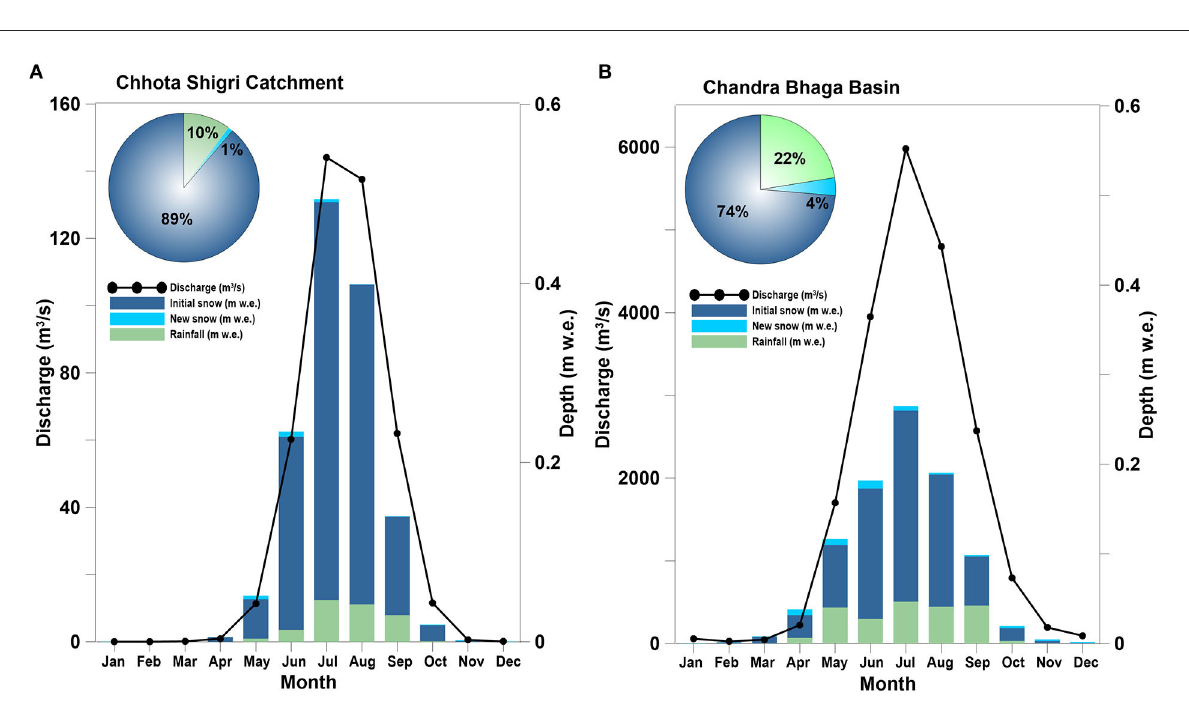
FIGURE10 Monthly hydrograph of total discharge (black line) and depth of different components contributing to the total discharge: initial snow (blue), new snow (sky blue), and rainfall (light green) over 2003–2018 for Chhota Shigri Catchment (A) and Chandra-Bhaga Basin (B) . The pie chart is showing the percentage contribution of each